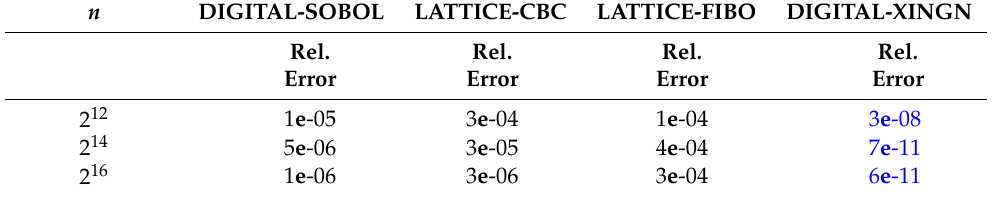
Table 6. RE for AE of f 0 ≈